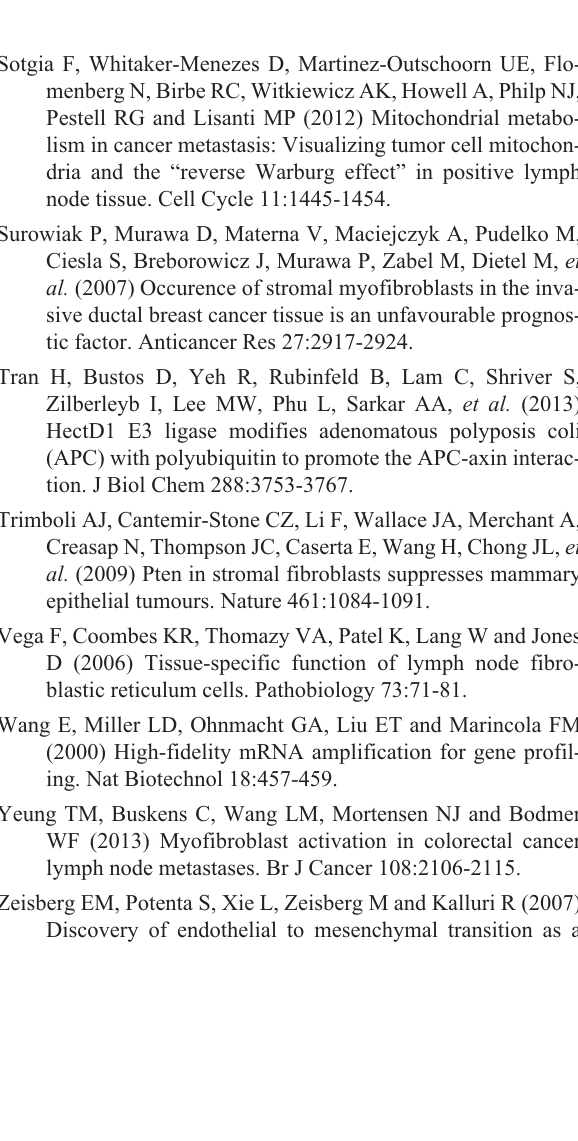
Table S3 - Functional annotation of biological processes of less expressed genes in stromal cells derived from bone marrow. Table S4 - Functional annotation of biological processes of more expressed genes in stromal cells derived from bone marrow. Table S5 - Top networks observed in Ingenuity Pathway Analysis (IPA). Figure S1 - Heat map of differentially expressed genes that gave no